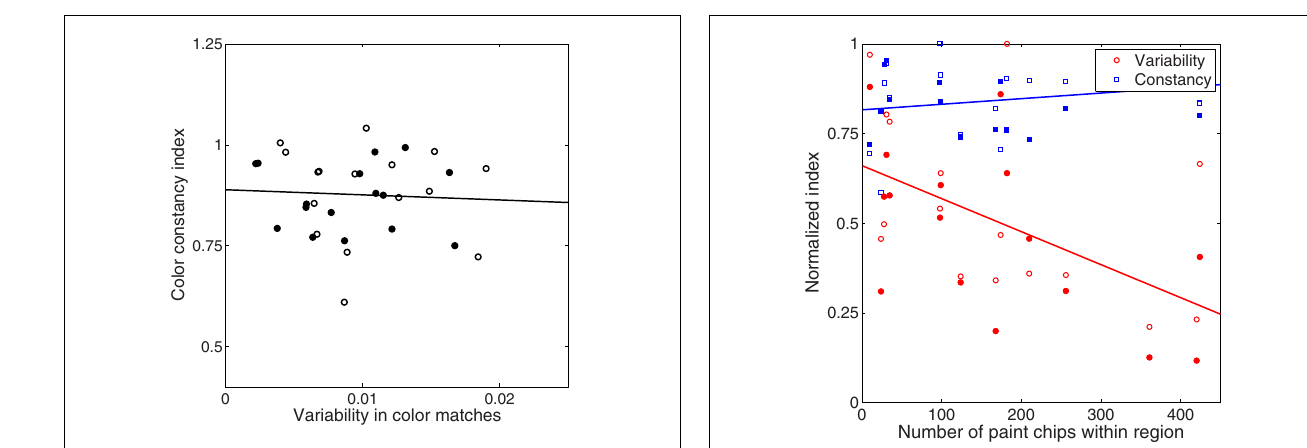
FIGURE 9 | Relationship between palette density (x-axis) and color constancy (blue symbols, y-axis) and variability (red symbols, y-axis) in the illumination (unfilled circles) and joint (filled circles) conditions. To aid in visualization, color constancy indices (red symbols) and variability values (blue symbols) were normalized to their respective maxima. All statistical tests in text were performed on non-normalized values. Lines are best fit to data collapsed across experimental